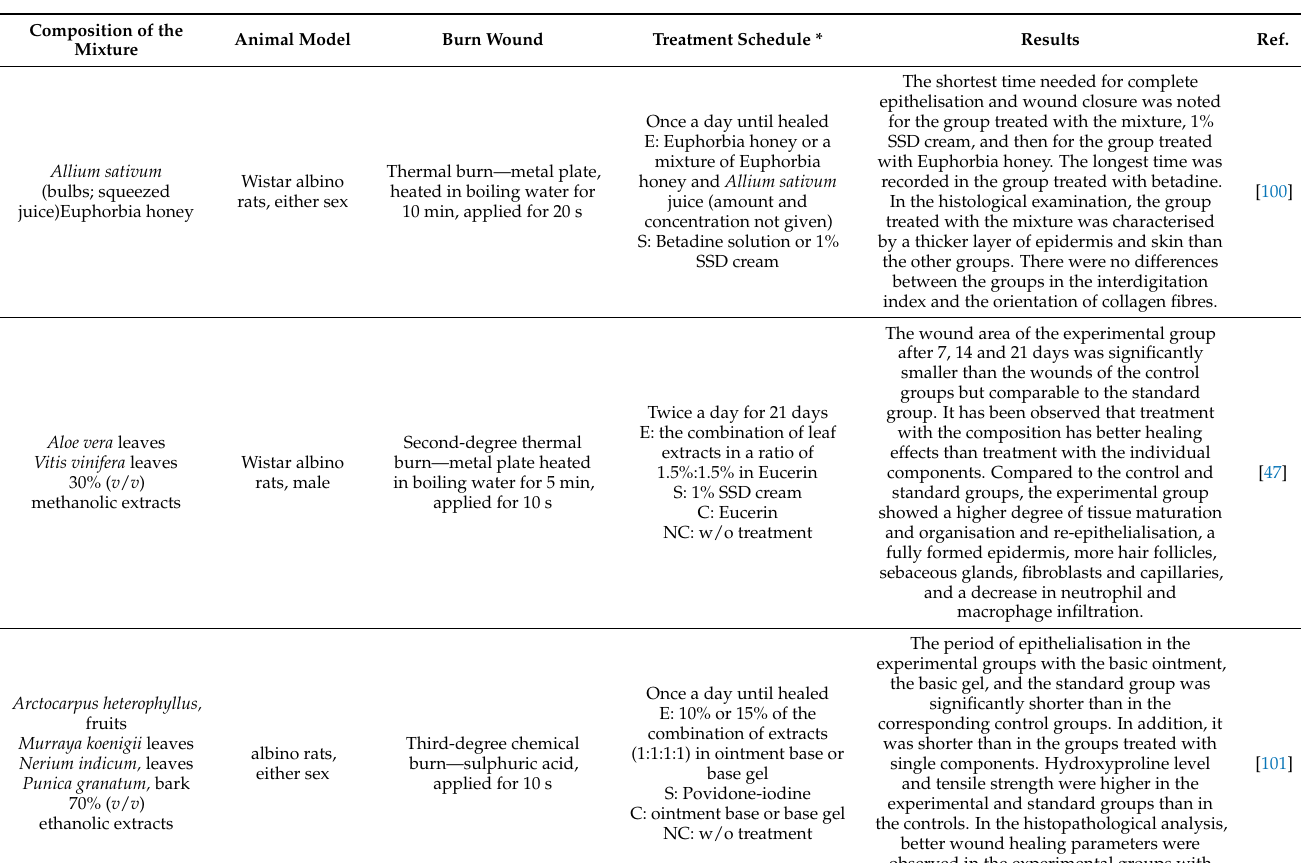
Table 2. In vivo studies on animal models—a mixture of